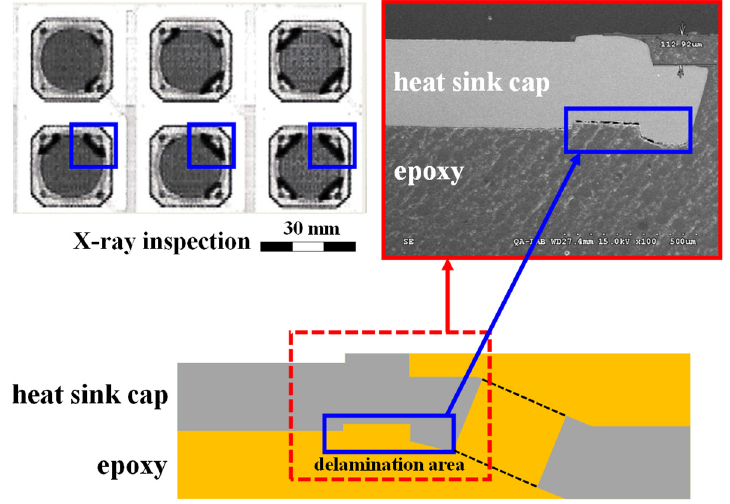
Figure 2. Delamination in PBGA packaging process.